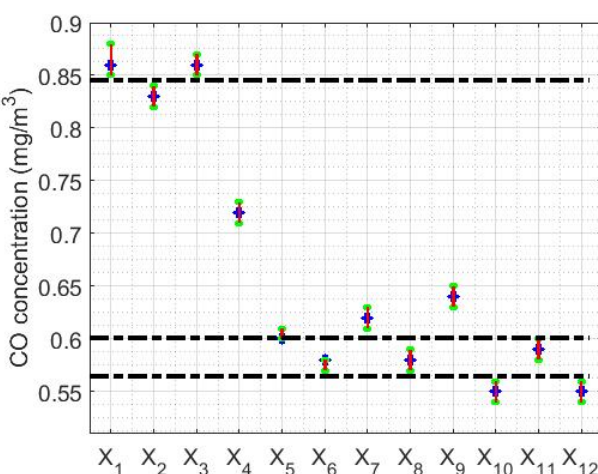
Figure 4. Confidence intervals for the median of each variable. The dashed lines are used to establish the separations between the different categories in which the variables under study are grouped.